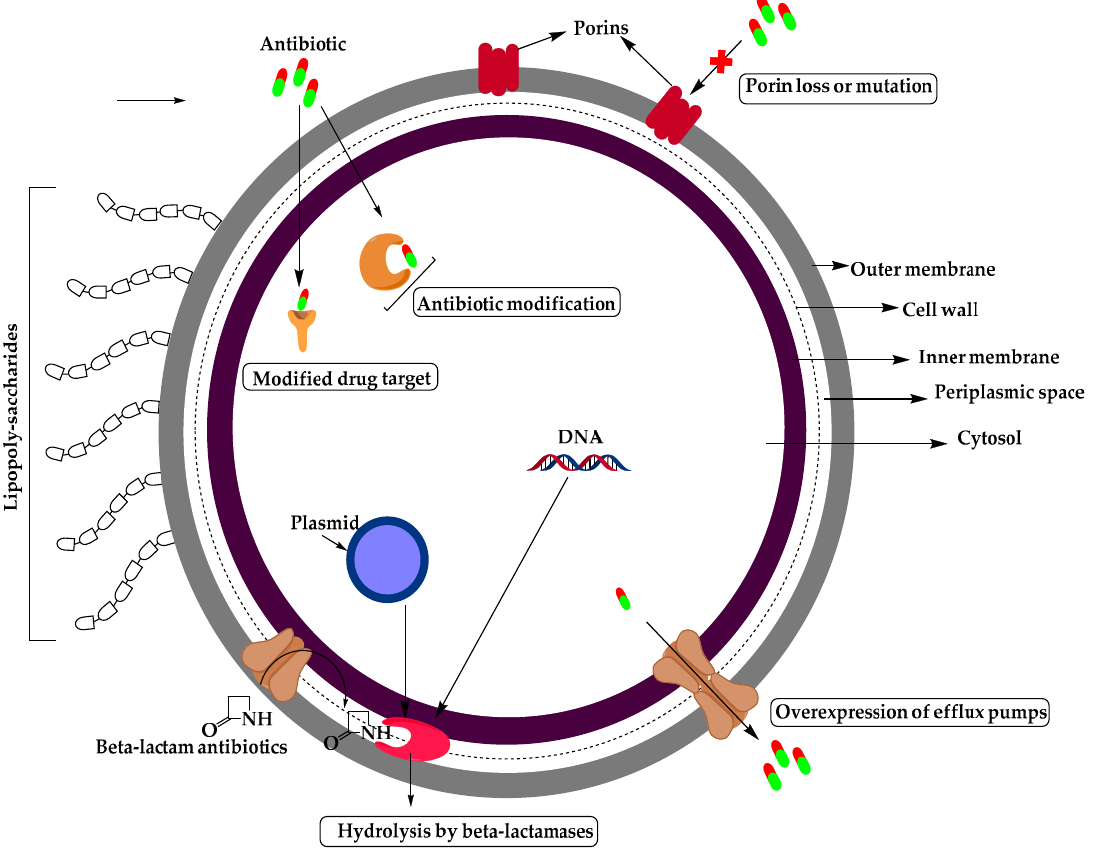
Figure 3. Structure of Gram-negative bacteria and their mechanisms of resistance.